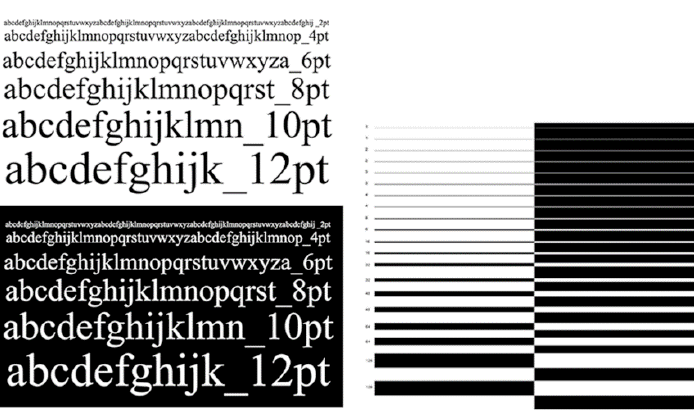
Figure 3. The part of the test form for analysis of line and text print quality in positive and negative shape.